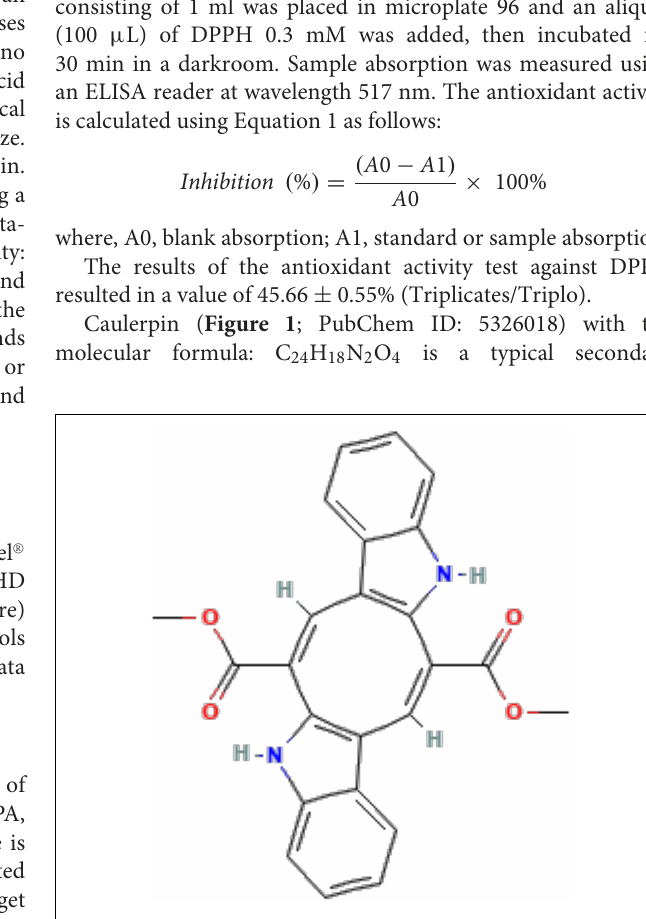
FIGURE 1 | Chemical structure depiction of caulerpin (PubChem ID: